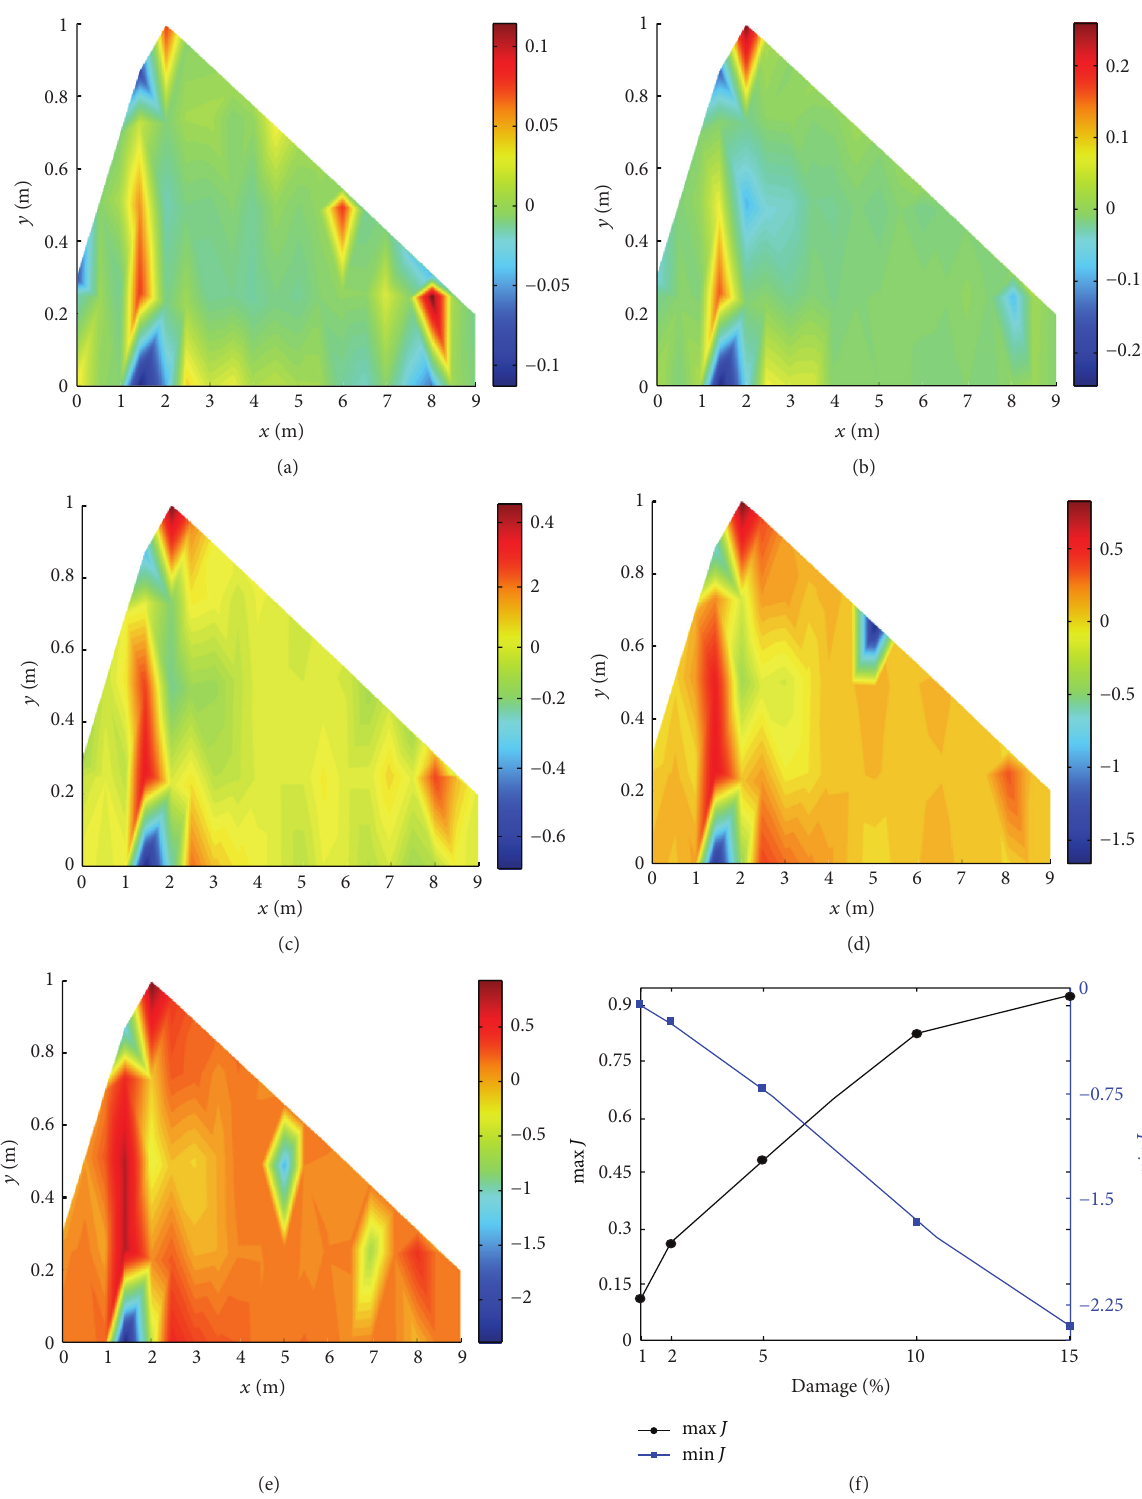
Figure 12: Damage maps 𝐽 for damage cases when considering the sparse sensor network of Figure 10 and Kriging interpolation. Damage corresponds to (a) 1%, (b) 2%, (c) 5%, (d) 10%, and (e) 15% reduction in the first natural frequency of the